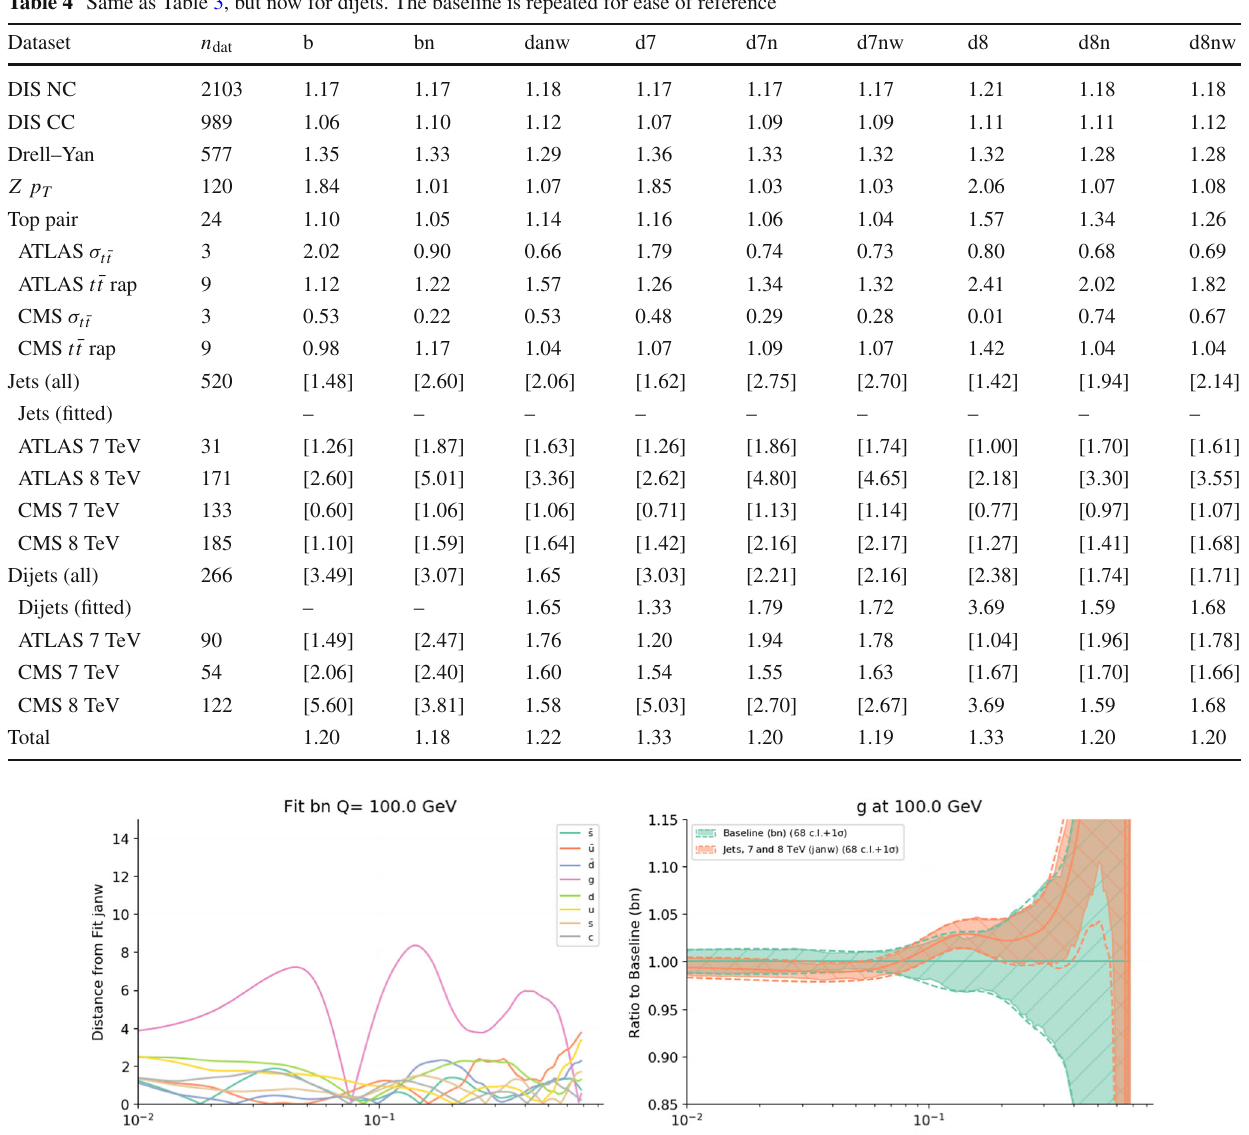
Fig. 6 Comparison between the baseline fit with no jet data (#bn) and the fit with all single-inclusive jet data included (#janw), both with default settings and the most accurate theory (NNLO QCD, including EW corrections for jets). The distance (see text) between all PDFs (left)